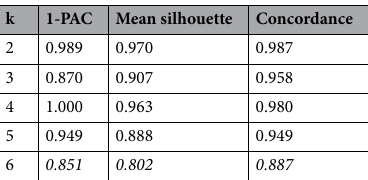
Table 1. Clustering evaluation indices for a maximum k of 6. Abbreviations: PAC, proportion of ambiguous clustering.